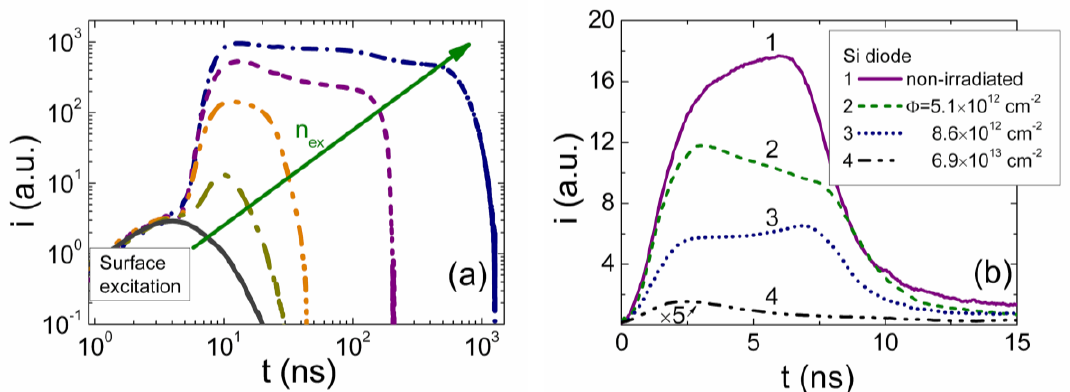
Figure 5. ( a ) Variation of current transients, registered in Si pad-detector biased with a fixed reverse voltage of value U  U , as a function of the injected charge density. FD ( b ) The current transients, ascribed to the charge domain injected by a laser pulse, as a function of 25 MeV neutron irradiation fluence, evaluated from the exposure time of the in situ